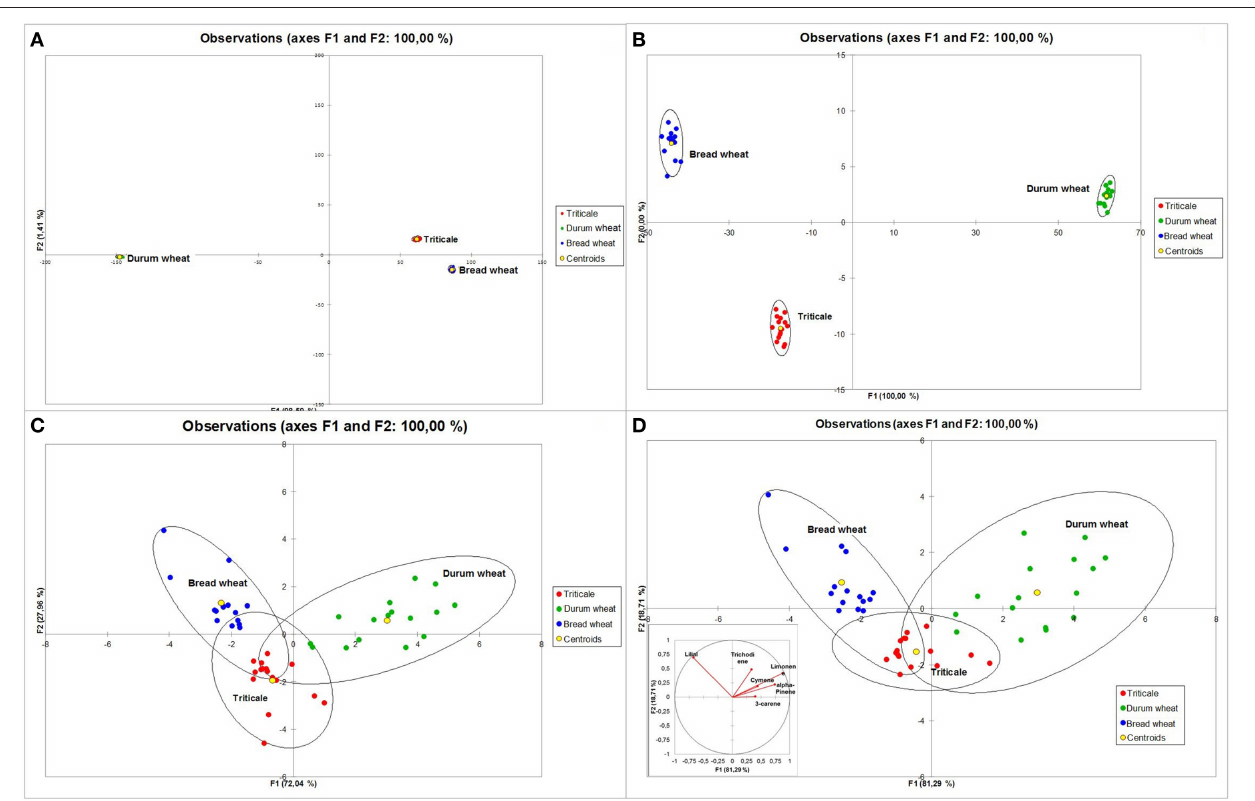
FIGURE 8 | Discriminant analysis (DA) for 46 identified VOCs—plot of observations (A), backward stepwise analysis—plot of observations (B), forward stepwise analysis—plot of observations (C) analyzed in 48 samples of cereal grain (triticale—red, durum wheat—green, and bread wheat—blue) and DA for terpenes—plot representing grain sample distribution and correlation circle